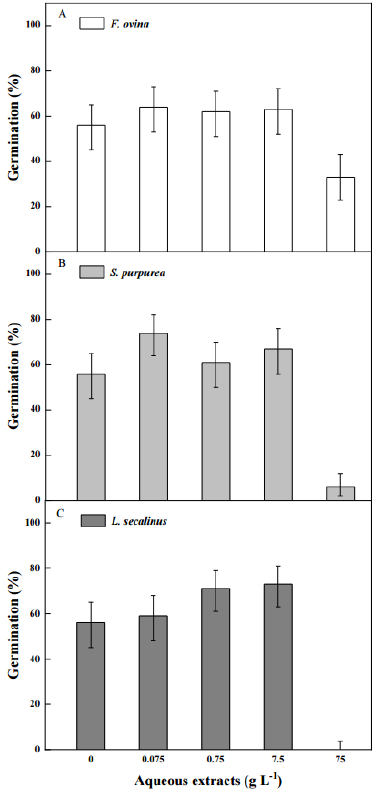
Figure 6. Germination percentage ( ± 95% binomial confidence intervals) of P. kansuensis seeds treated with different contents of aqueous extracts of three native dominant plants (( A ), F. ovina ; ( B ), S. purpurea ; ( C ), L. secalinus ) in 12 h light/12 h dark at 10/25 ◦